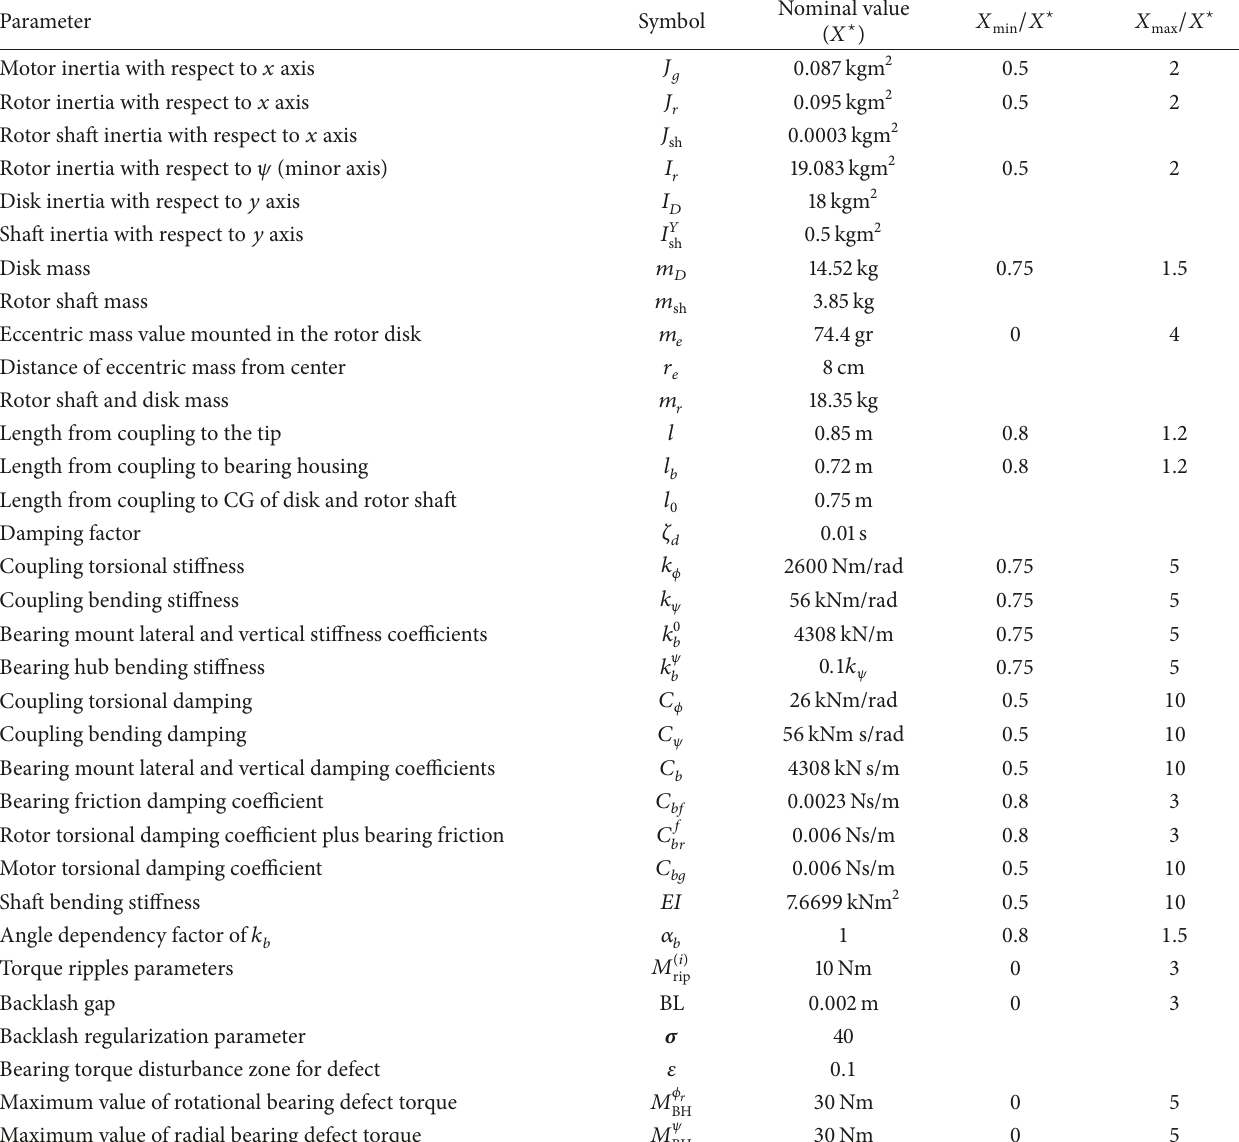
Table 1: Test rig nominal and randomized input